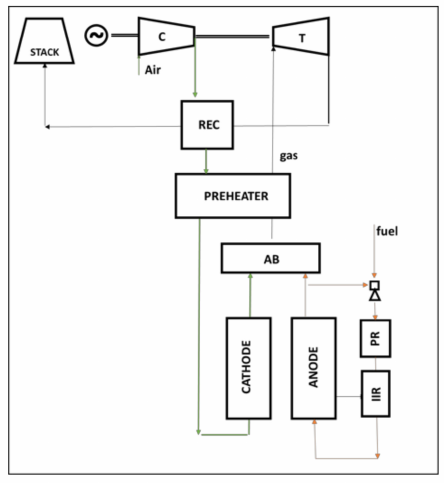
Figure 11. SOFC—MGT system